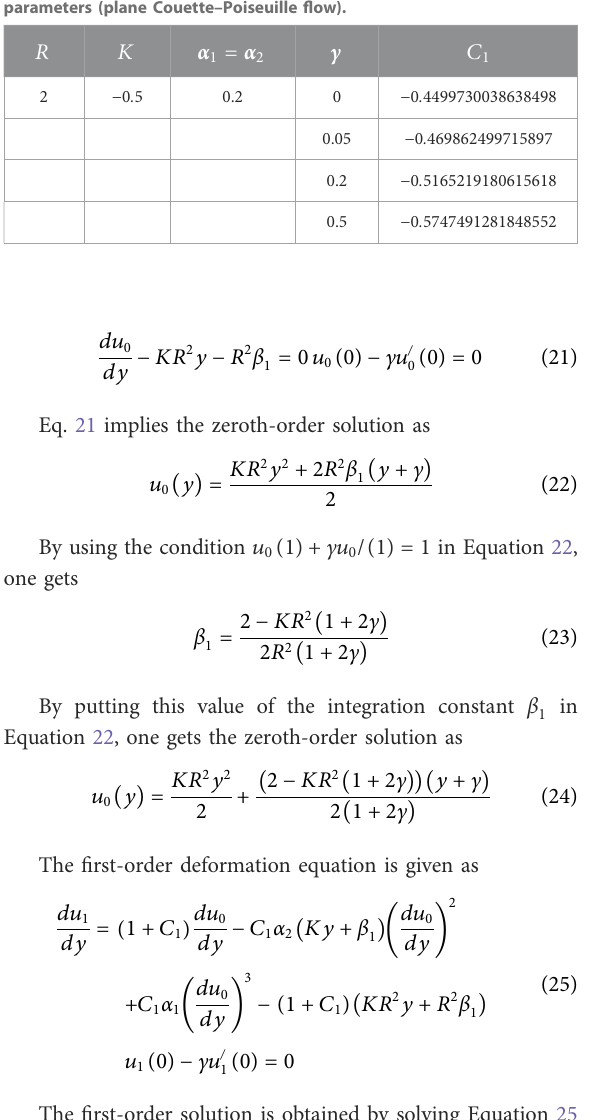
for different slip 1